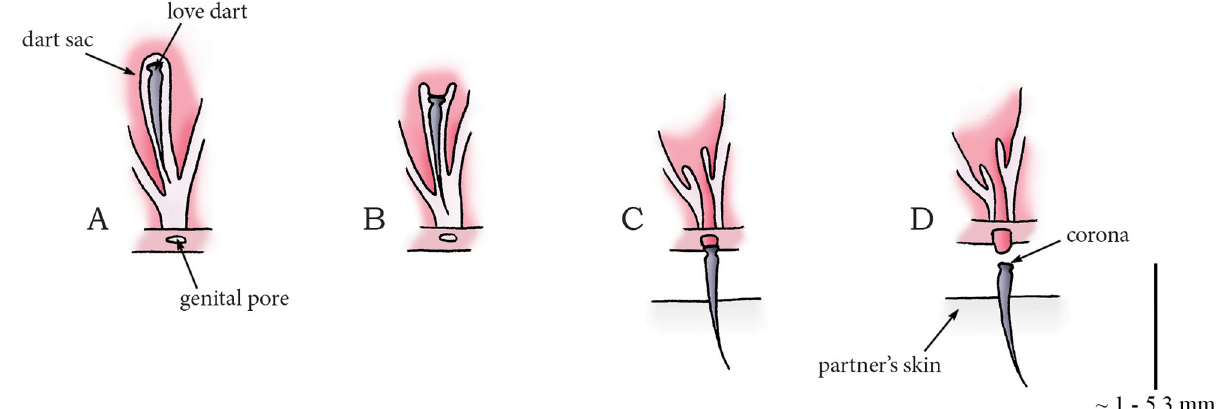
Fig 27. Muscle-powered eversion catapult mechanism in the clade Stylommatophora (species Cornu aspersum ). (A) The dart organ morphology, consisting of a fully developed love dart and a muscular dart sac. (B) Eversion of the dart sac, forcing the love dart to be externalized through the genital pore. (C – D) Piercing and release (at the corona) of the love dart into the mating partner. Drawings based on schematic drawings in [145]. Scale bare indicates the length of the love dart, which is in between 1 – 5.3 mm in length (longest dart found in Chilostoma cingulatum